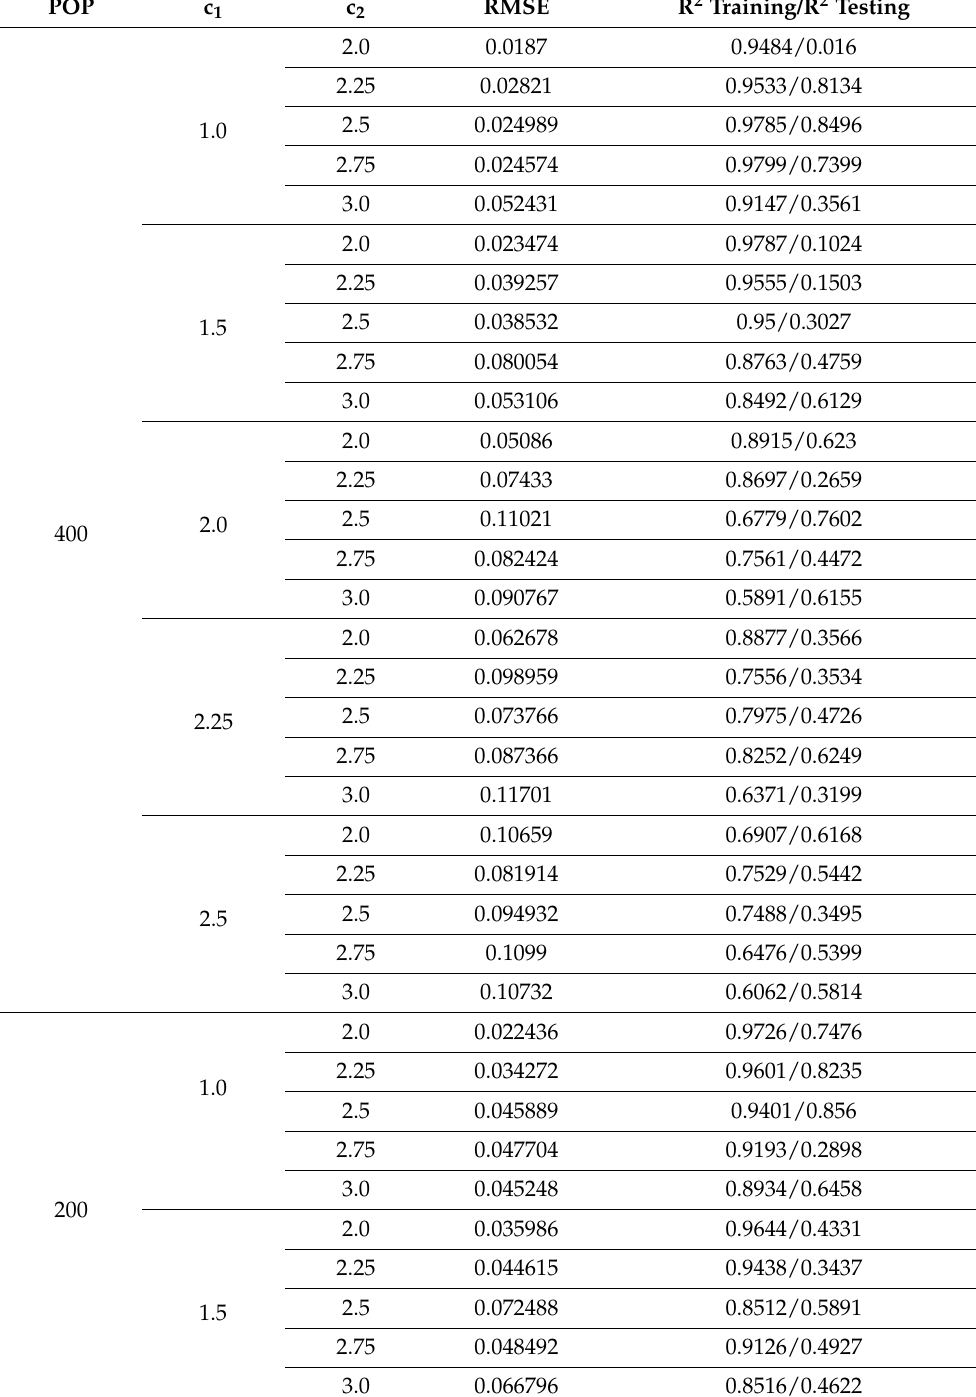
Table 7. ANFIS-PSO